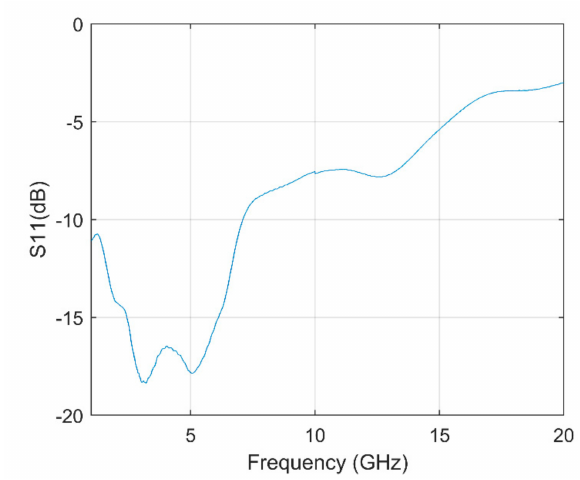
Figure 3. Measured return loss S 11 of the proposed